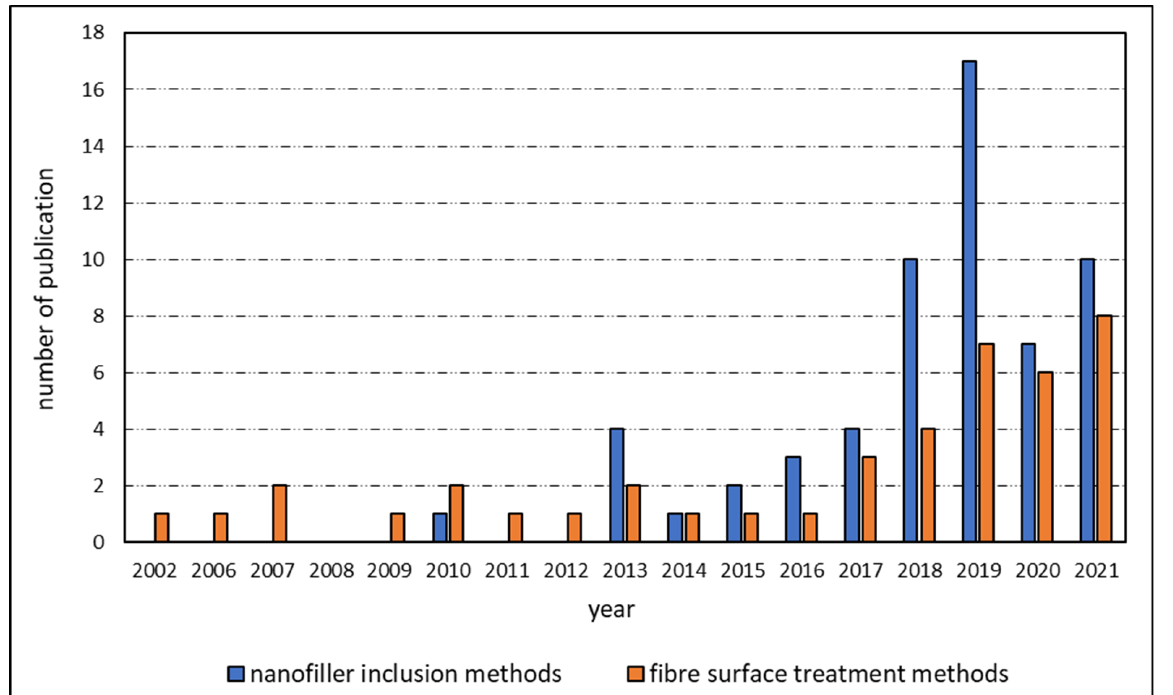
Figure 1. Survey of research papers related to interfacial engineering of thermoplastic composites.